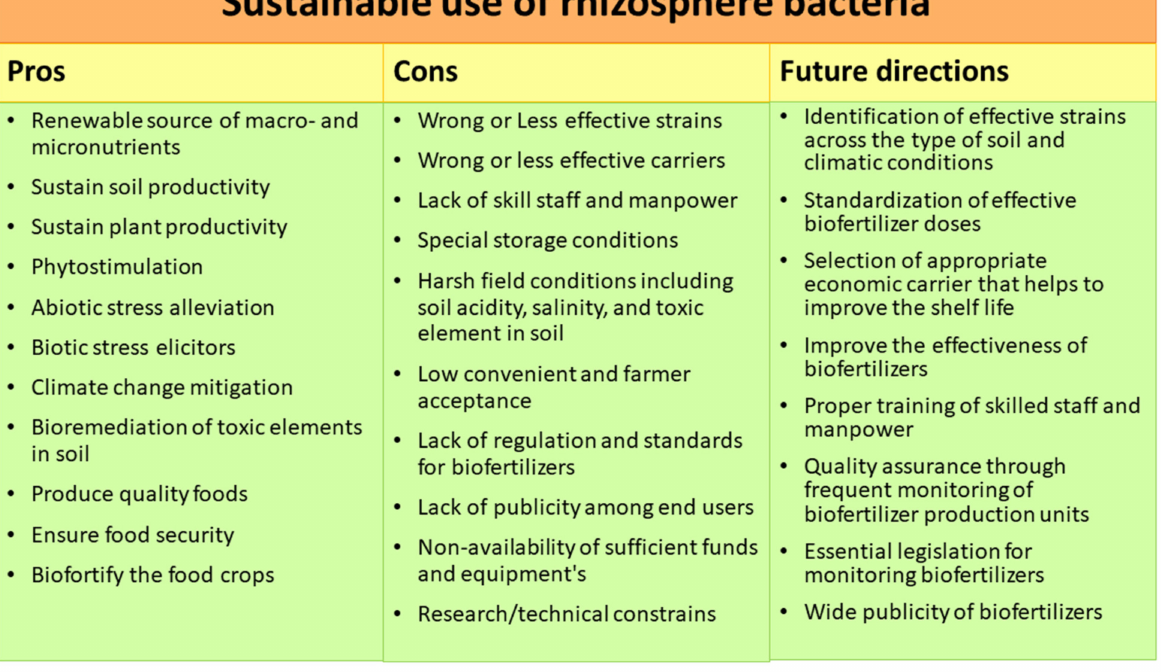
Figure 3. Comparison of pros and cons of rhizobacterial application for sustainable agriculture with possible future directions